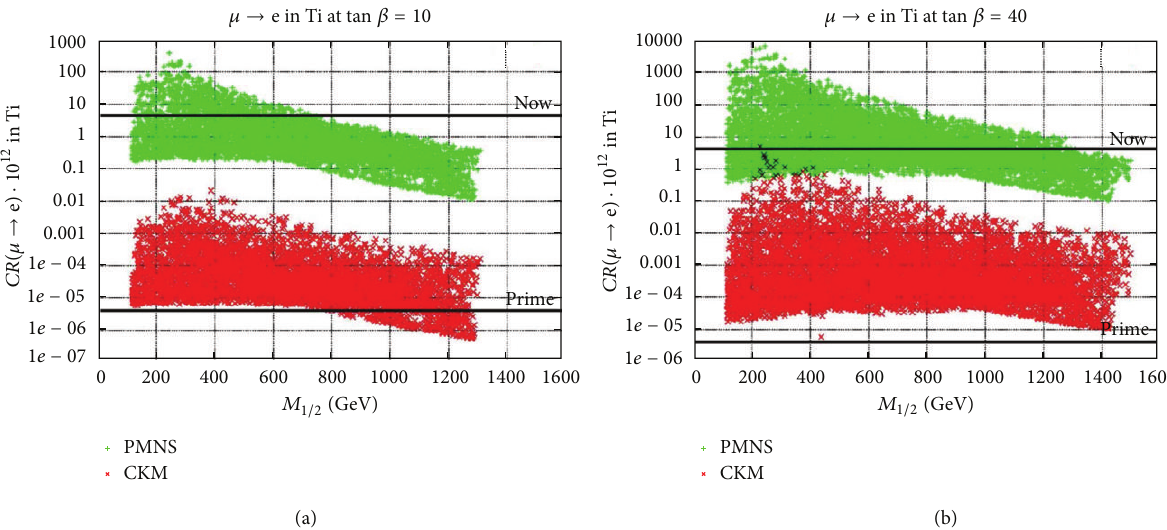
Figure 22: Example of predictions for 𝜇 − 𝐴 → e − 𝐴 conversion on Ti in SUSY models as a function of the gaugino mass 𝑀 1/2 . (a) tan 𝛽 = 10 ; (b) tan 𝛽 = 40 [112]. The green and red points correspond to optimistic (PMNS) or pessimistic (CKM) predictions on the mixing parameters. The experimental upper bound [115, 116] and the expected sensitivity of the new generation PRISM experiment are also shown [117].